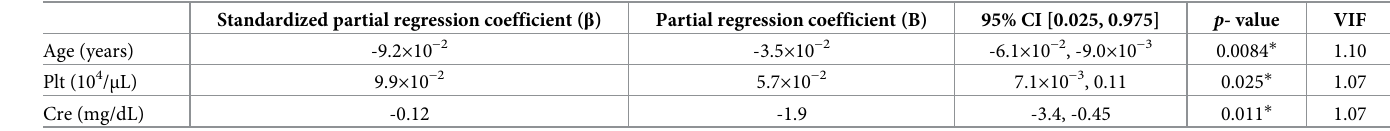
Table 5. Multivariable linear mixed effects model regression analysis between amplitudes and explanatory variables. Standardized partial regression coefficient ( β